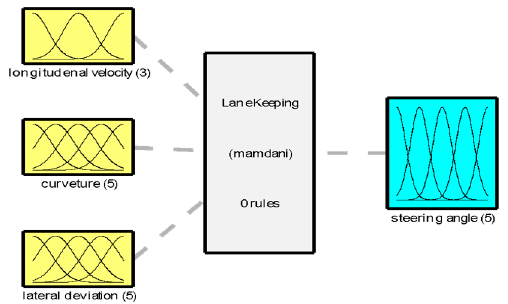
Figure 4. Fuzzy lane-keeping system architecture.